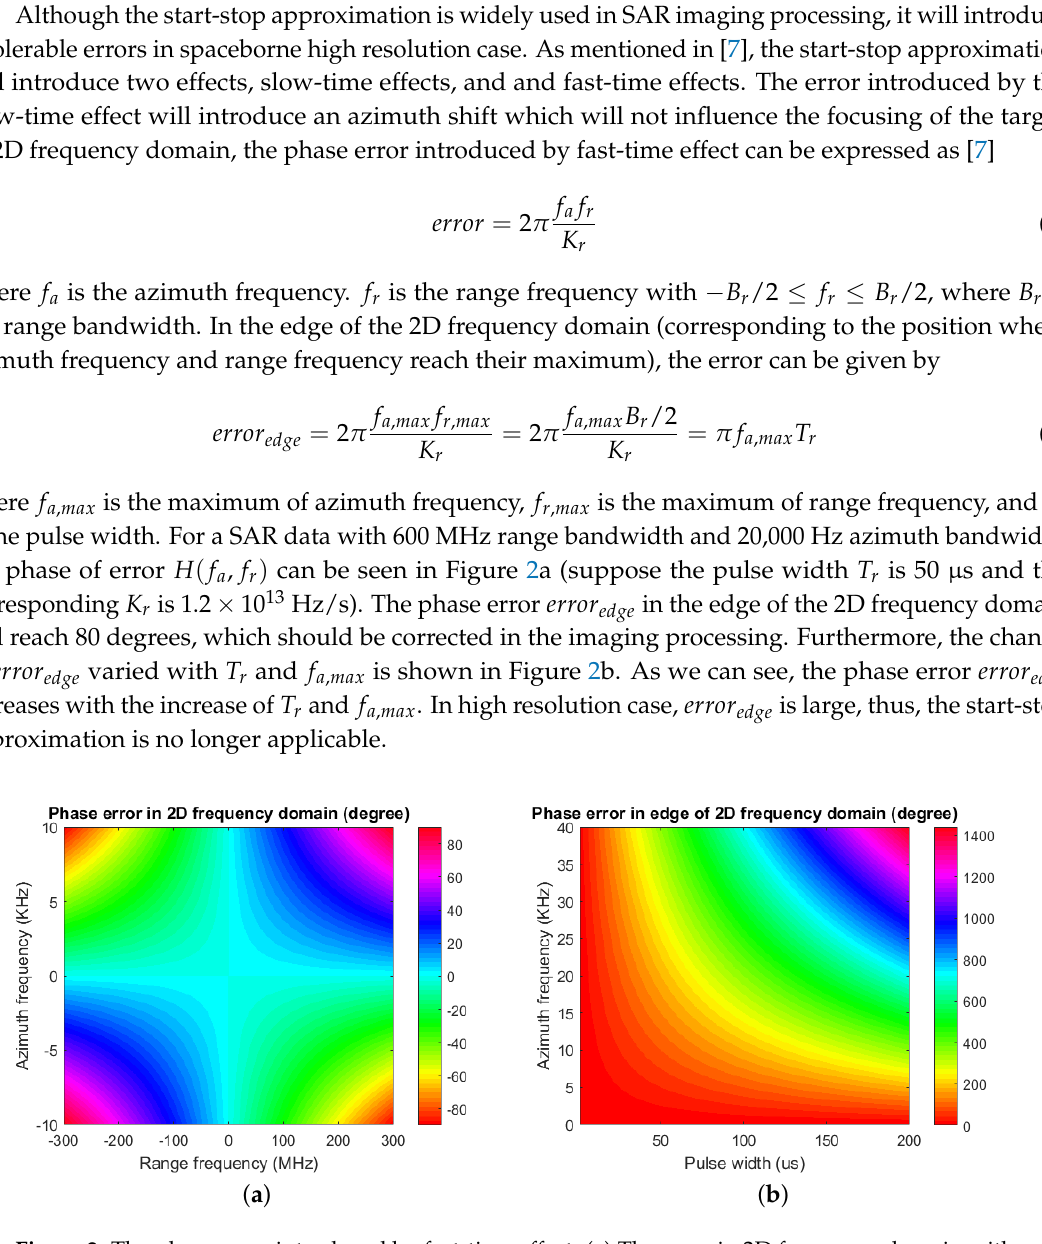
Figure 2. The phase error introduced by fast-time effect. ( a ) The error in 2D frequency domain with 600 MHz range bandwidth and 20,000 Hz azimuth bandwidth ( b ) the edge error error edge varies with pulse width T r and the maximum of azimuth frequency f a , max